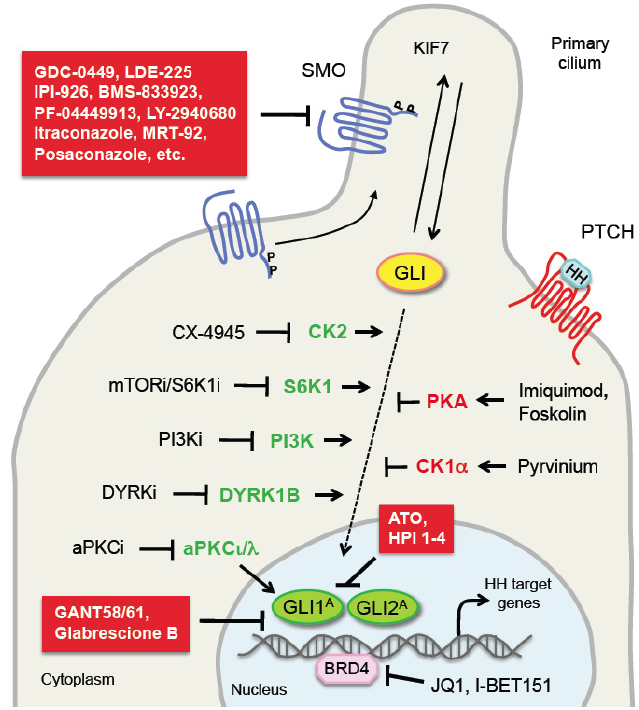
Figure 2. Targeting the Hedgehog pathway. Inhibition of the HH pathway by direct SMO and GLI inhibitors (red boxes) and by small molecules or drugs targeting protein kinases. Indicated are protein kinases that act as negative regulators (red) and positive regulators (green) of the GLI. For each protein kinase agonists and antagonists are reported. For details regarding the inhibitors and their target or mechanism of action see Table 1. Abbreviations: SMO, Smoothened; PTCH, Patched; KIF7, kinesin familymember7; HH,Hedgehog; GLI1 / 2 A , GLI1 / 2activators; CK1 α , caseinkinase1 α ; CK2, caseinkinase 2; PKA, protein kinase A; S6K1, ribosomal protein S6 kinase 1; PI3K, phosphatidylinositol-3-kinase; DYRK1B, dual specificity tyrosine-phosphorylation-regulated kinase 1B; aPKC ι / λ , atypical protein kinase ι / λ ; BRD4, bromodomain-containing protein Table 2. Hedgehog pathway antagonists and other inhibitors mentioned in the text and in Figure 2. Inhibitor Pathway Target/Mechanism